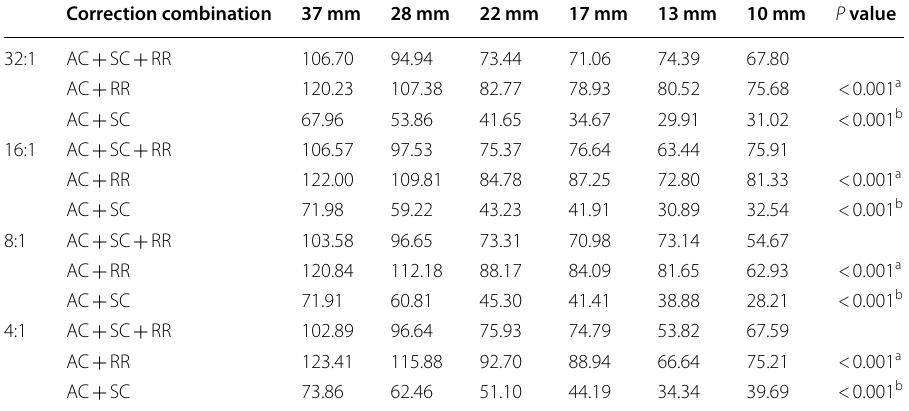
Reconstruction parameters: 35 iterations, 20 subsets, no filter; Acquisition parameters: 120 s/frame of acquisition time, 15% main energy window; AC, attenuation correction; SC, scatter correction; RR, resolution recovery correction; a, AC vs. AC RR; b, AC SC RR vs. AC SC + + + +